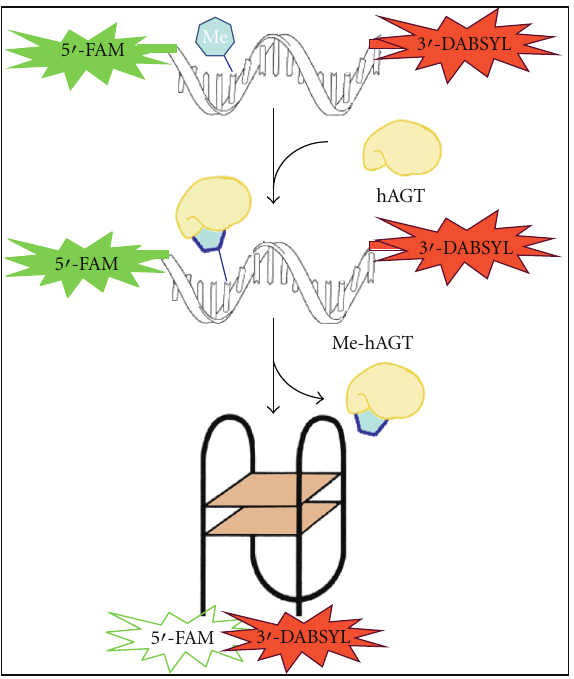
Figure 1: Scheme of fluorescence-based hAGT assay. The sub- strate is the thrombin-binding aptamer modified by an O 6 - methylguanine (Me) in extended conformation, with a fluorophore and quencher in the opposite ends of the sequence. The refold of the G-quadruplex structure of TBA is dependent on the removal of the methyl adduct by alkyl-guanine-DNA-O 6 -alkyltransferase (hAGT). This repair moves the quencher and the fluorophore molecules in close proximity and blocks fluorescence.